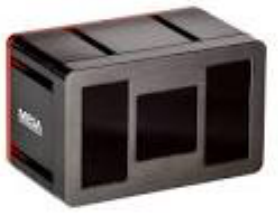
Figure 1. Picture of the SR4500 ToF camera view of 69 ◦ × 55 ◦ . A sample acquisition is shown on Fig. 2. The scene is taken in a technical hall, with an optical bench and a test vehicle. Its depth varies from 0 to 10 m. The left image shows the depth map (in false colors), where the depth gradient along the bench is clearly visible, along with some noisy pixels. The center image is the intensity image in the infrared which is, of course, slightly different from the rightmost photograph.